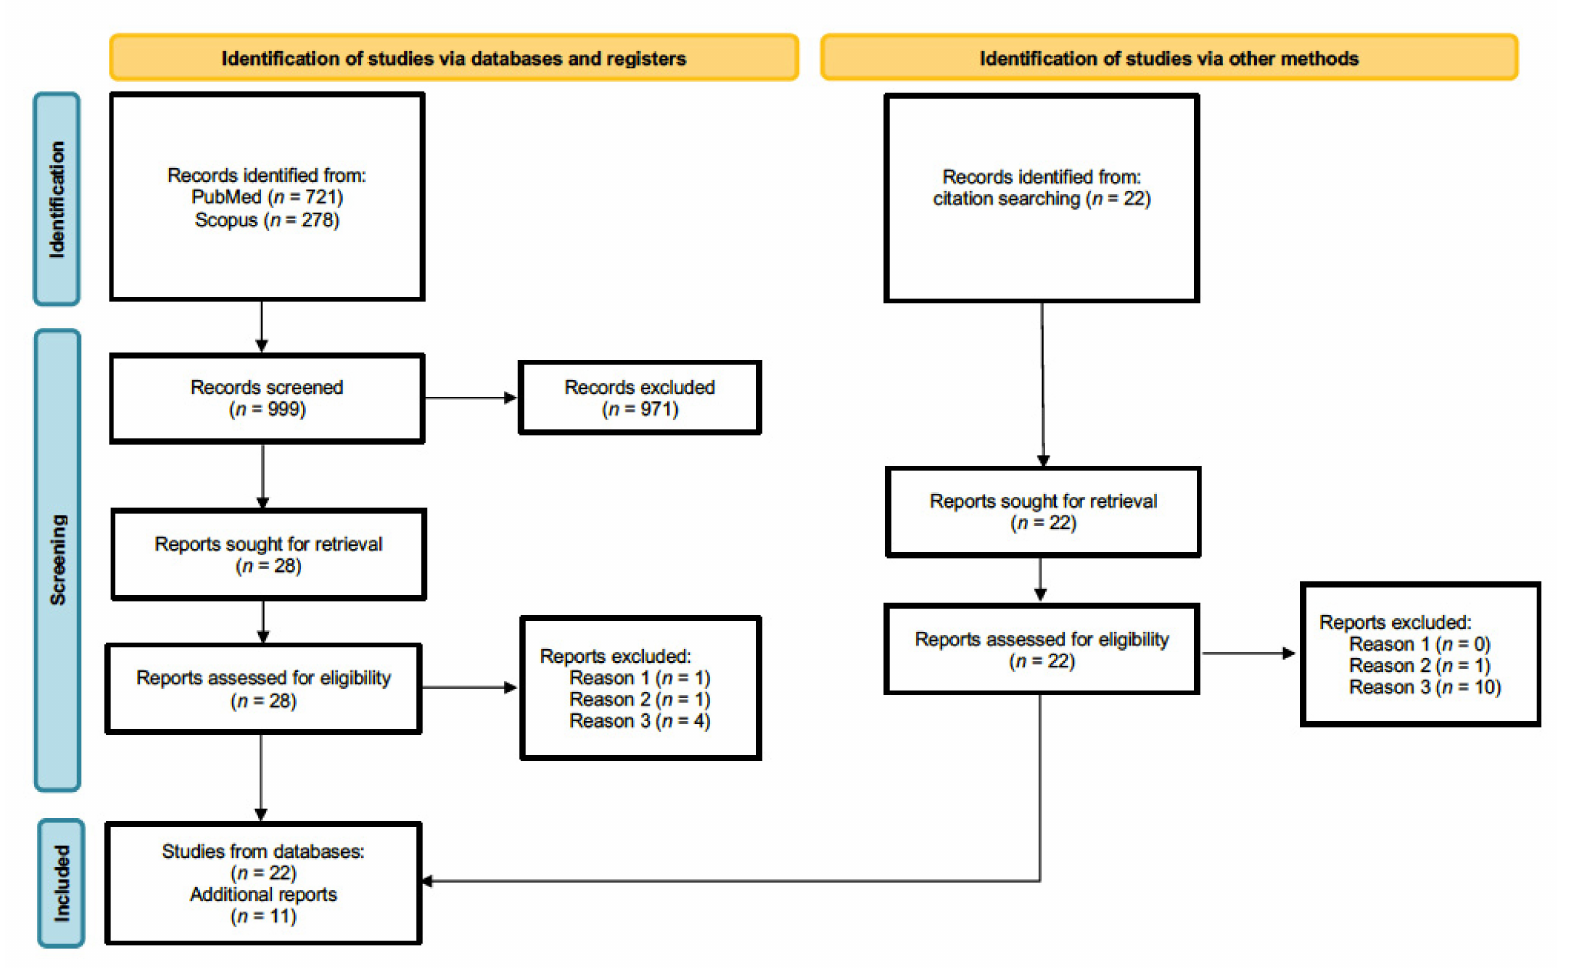
Figure 1. Study flow chart. Reason 1: do not investigate neural basis of maternal love [48]. Reason 2: articles on clinical populations [49,50]. Reason 3: do not report hypothalamic